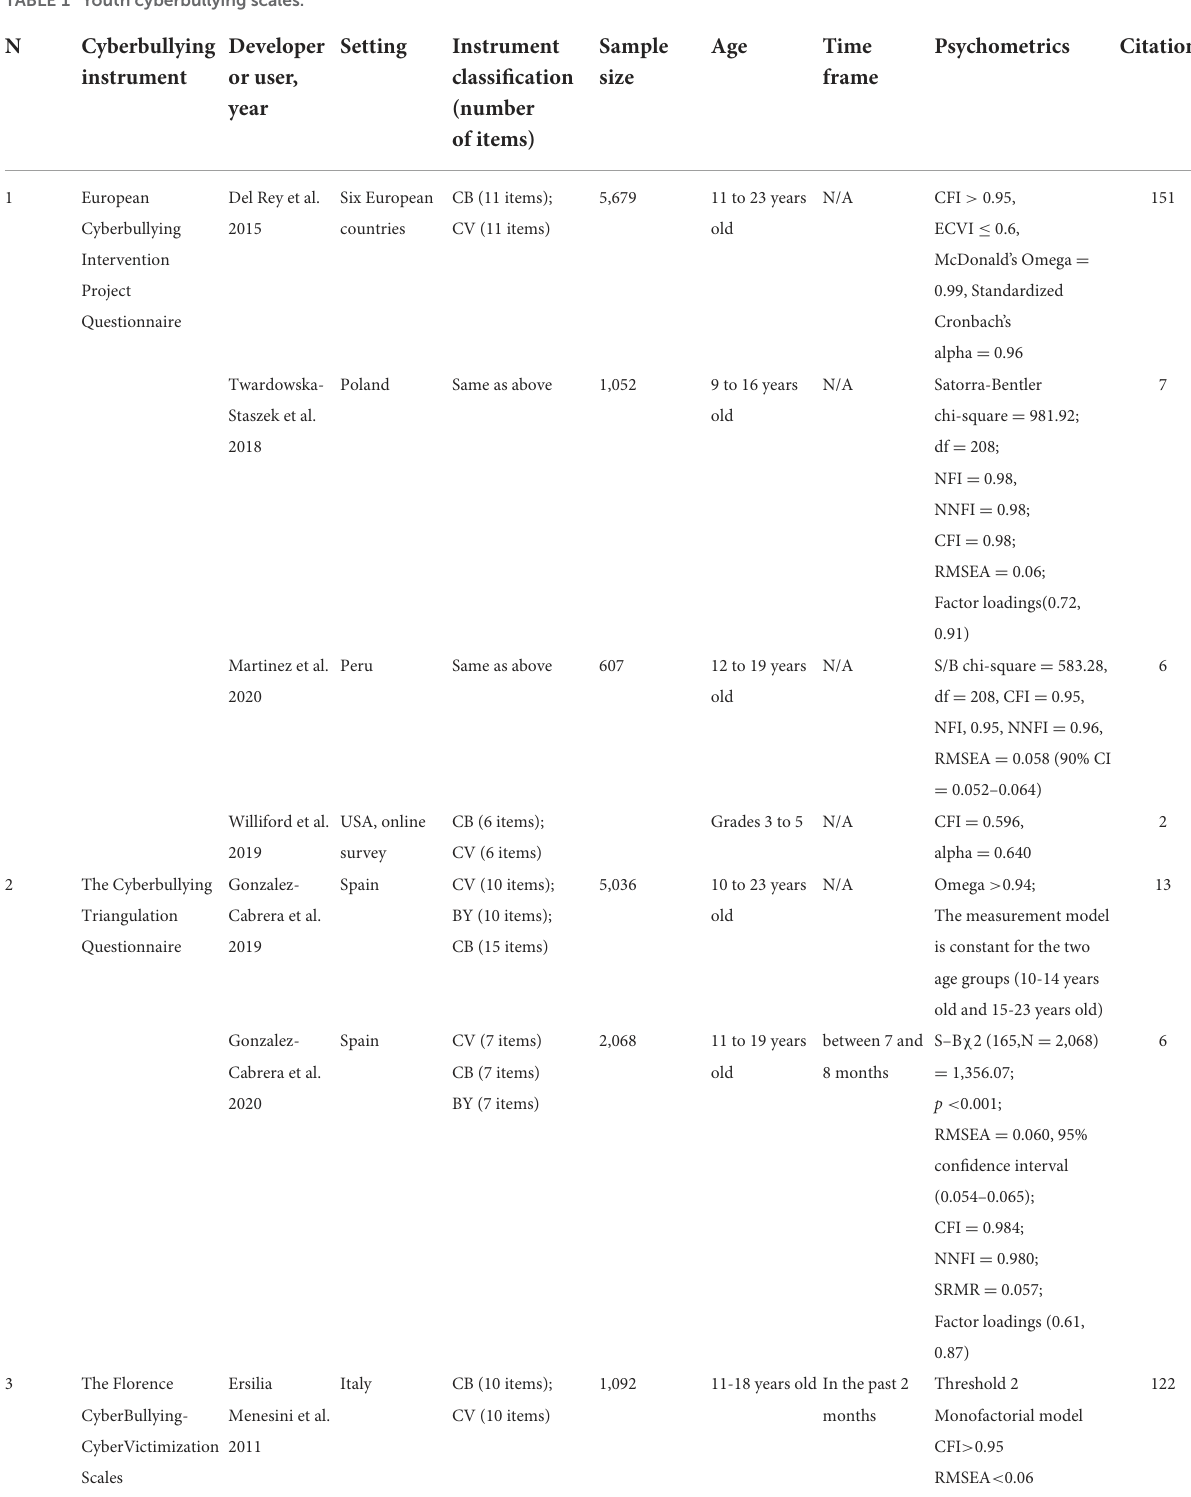
TABLE 1 Youth cyberbullying